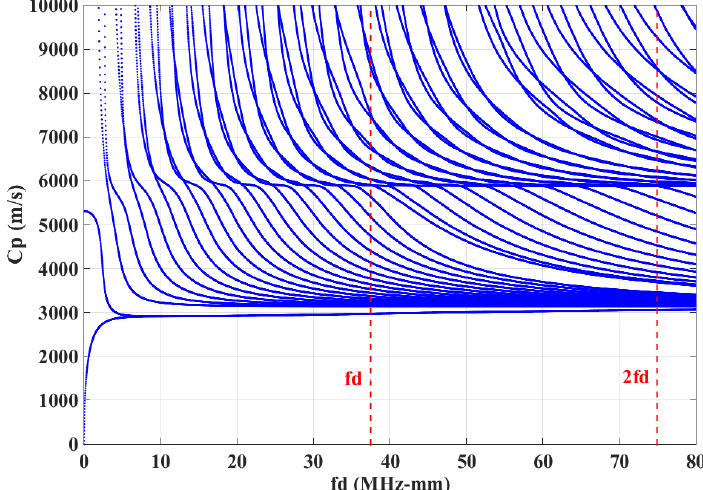
Figure 3. Phase velocity dispersion curves of isotropic steel plate.